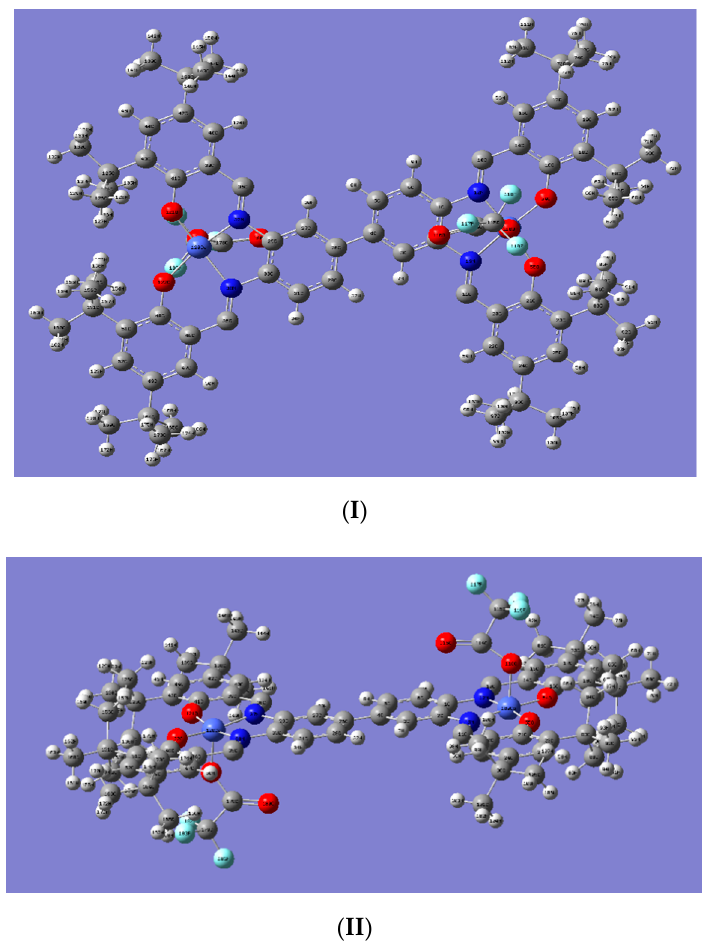
Figure 4. Structure of optimized (salen- 4 )[Co(III)TFA] 2 ; ( I ) is the main view, ( II ) is the top view. Table 7. Frontline molecular orbital